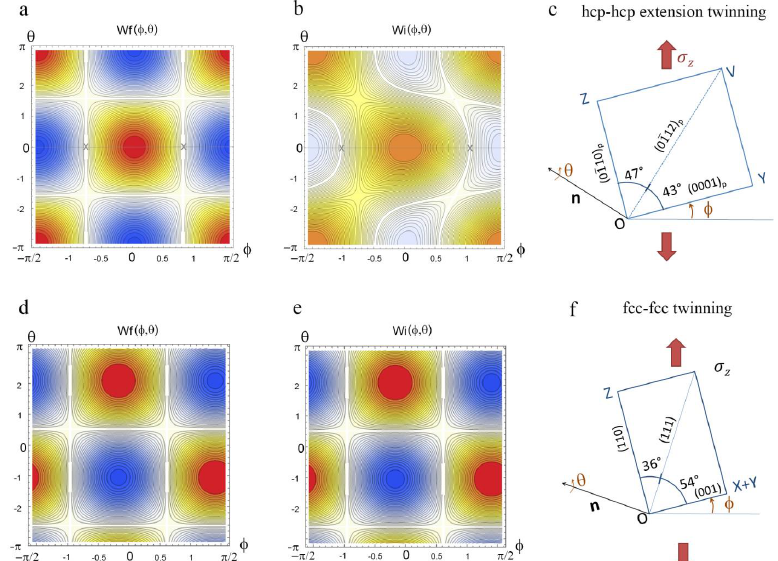
Figure 29. Interaction work during a tensile stress along the z -axis of a parent crystal, tilted by an angle Φ around the x -axis and rotated by an angle θ around the n -axis (normal to the twinning plane), with ( a – c ) for extension twinning in hcp metals, and the x -axis being the [100] axis. ( d – f ) For fcc-fcc deformation twinning, the x -axis is the [ 1(cid:3364) 10] axis. ( a , d ) Interaction work W f calculated with the complete distortion (simple shear) matrix. W f is proportional to the usual Schmid factor. ( b , e ) Interaction work W i calculated with the intermediate distortion matrix corresponding to the maximum volume change. ( c , f ) Schematic view of the orientation of the parent crystal. The distortion matrix of extension twinning in hcp metal is given in [130]. The distortion matrix for fcc-fcc deformation twinning is given in [123].